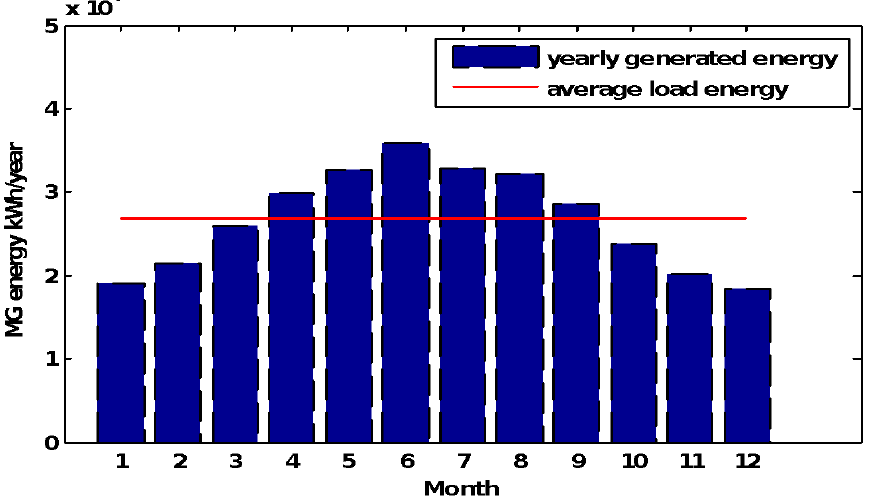
Figure 9. Grouped load profile sharing with 6884 kg emissions